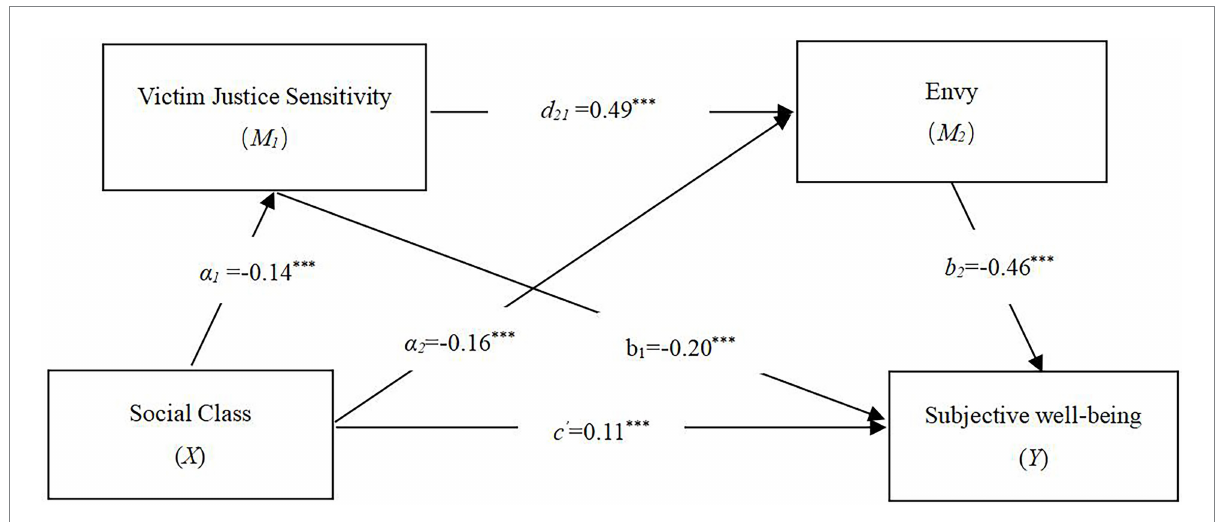
FIGURE 2 Path analysis models of the effects of social class, victim justice sensitivity, envy, and subjective well-being in Chinese undergraduates. *** p < 0.001.